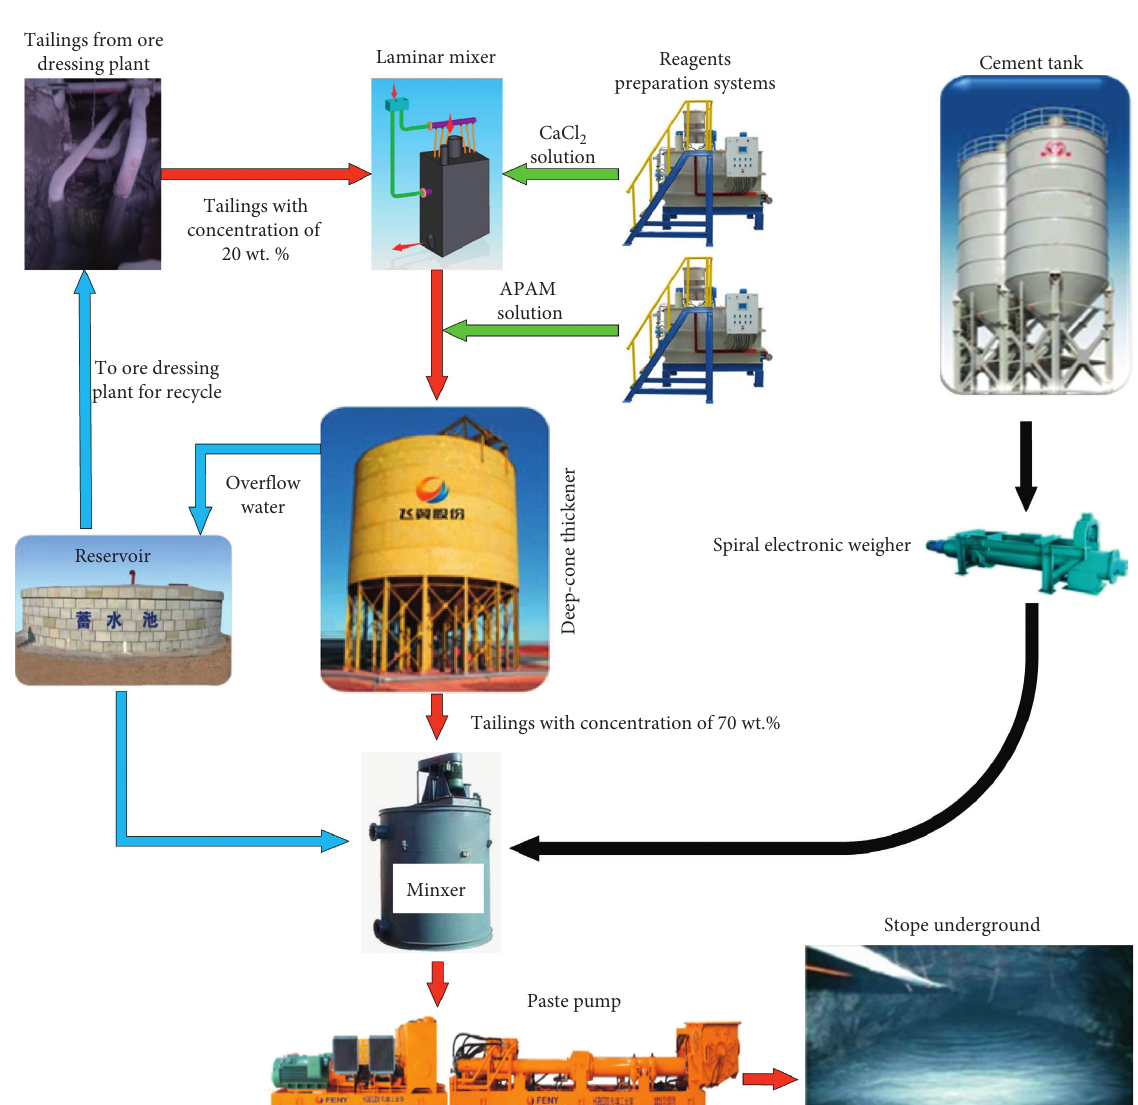
Figure 13: Backfill setup with new FS technology in